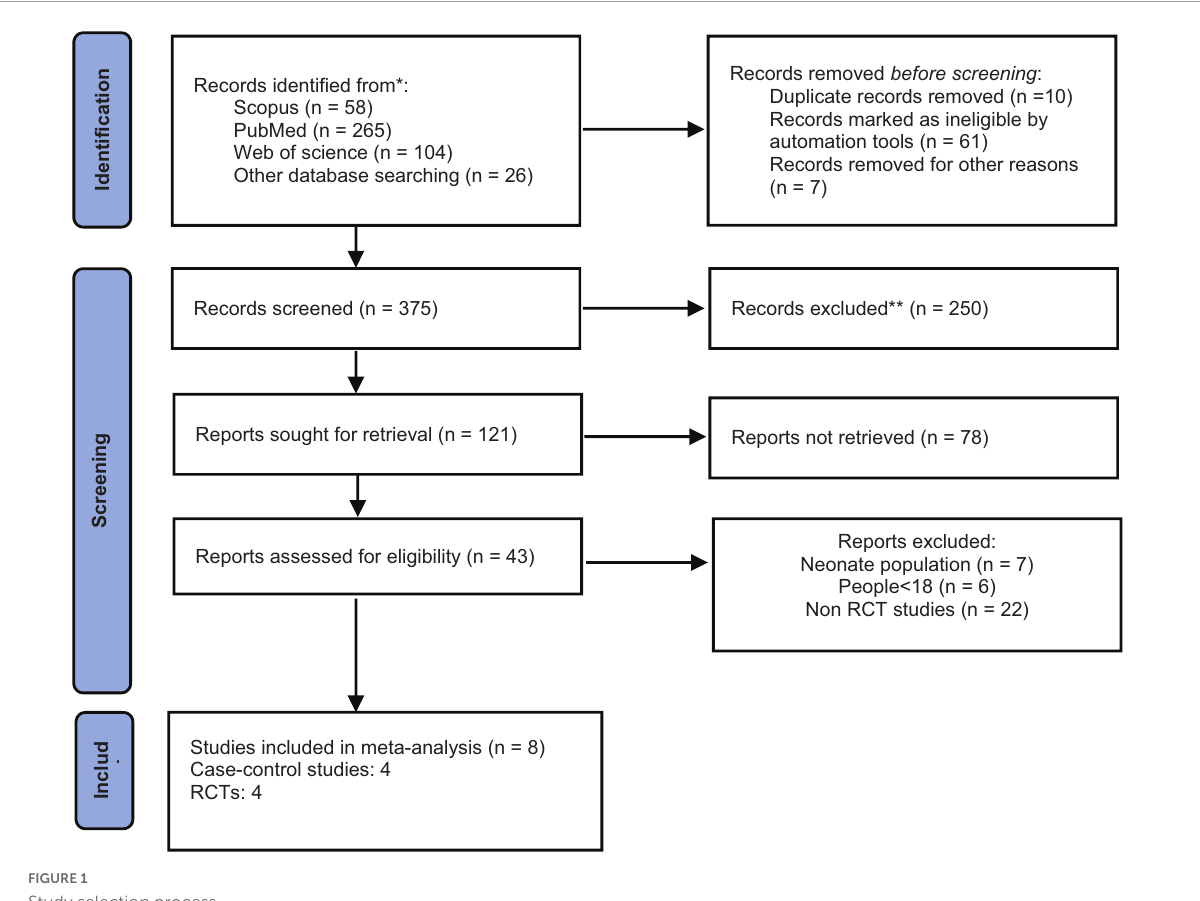
FIGURE1 Study selection